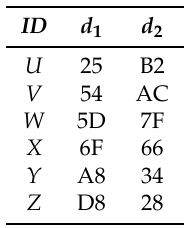
Table 2. Secure skyline objects set, Sky ( DS 2 ) of DataNode 2